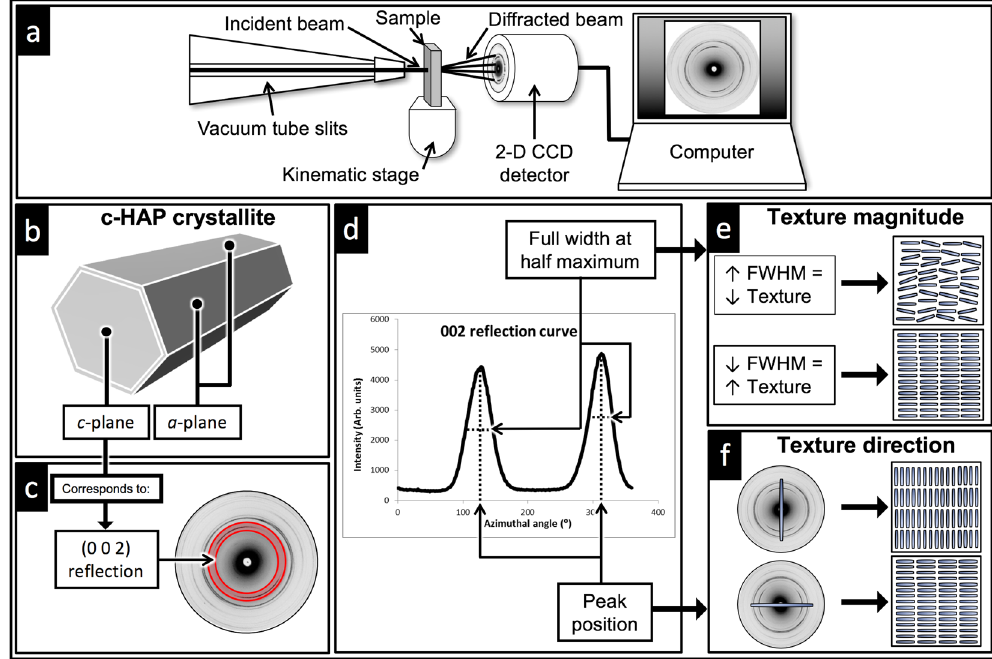
Figure 11. A diagram showing the ( a ) S-XRD experimental setup and the relation between ( b ) the c -axis of a c-HAp crystallite and ( c ) the (002) reflection in a typical diffraction pattern. ( d ) The azimuthal 1-D profile of the (002) reflection obtained from the deconvolution of the 2-D diffraction patterns can be used to determine crystalline texture ( e ) magnitude and ( f )